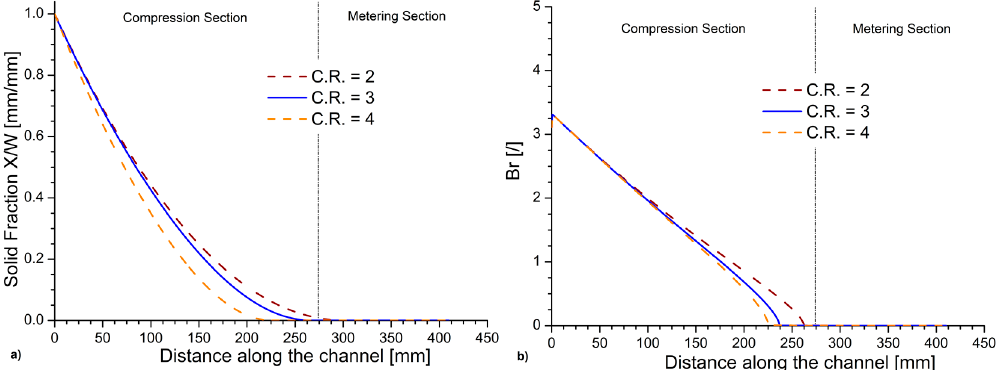
Figure 9. ( a ) Melting profile; and ( b ) Brinkman number for different compression ratios (C.R. values) considering otherwise the micro-extrusion settings and material parameters of Table 1 (Column 2). Blue (reference) lines as in Figure 4.